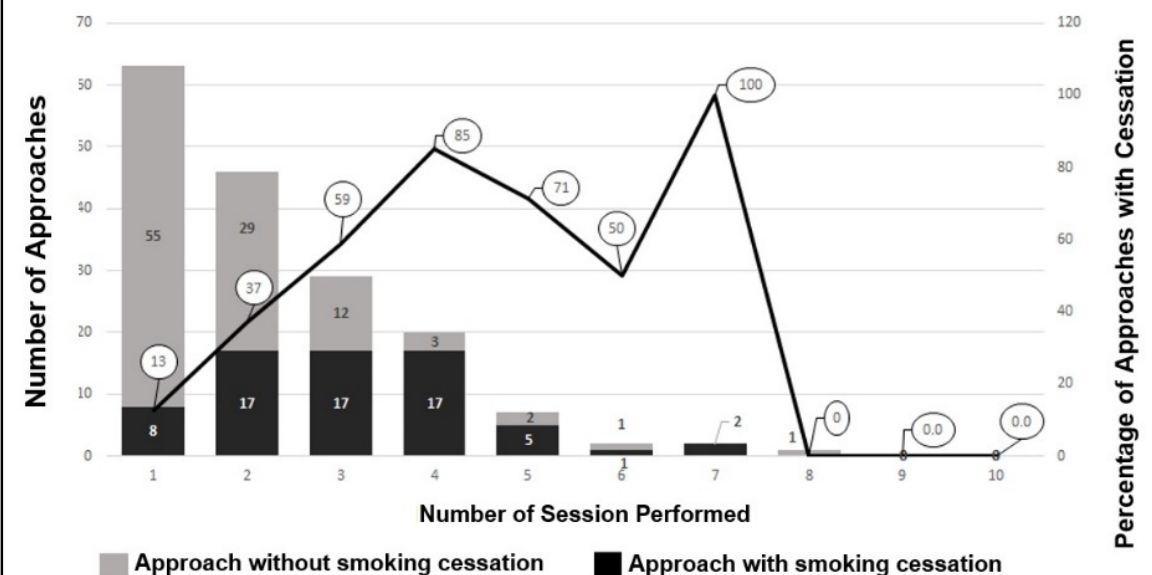
Figure 1. Incidence of smoking cessation in the pharmaceutical service with individual approaches. 2018–2019. Belo Horizonte—MG. Brazil.